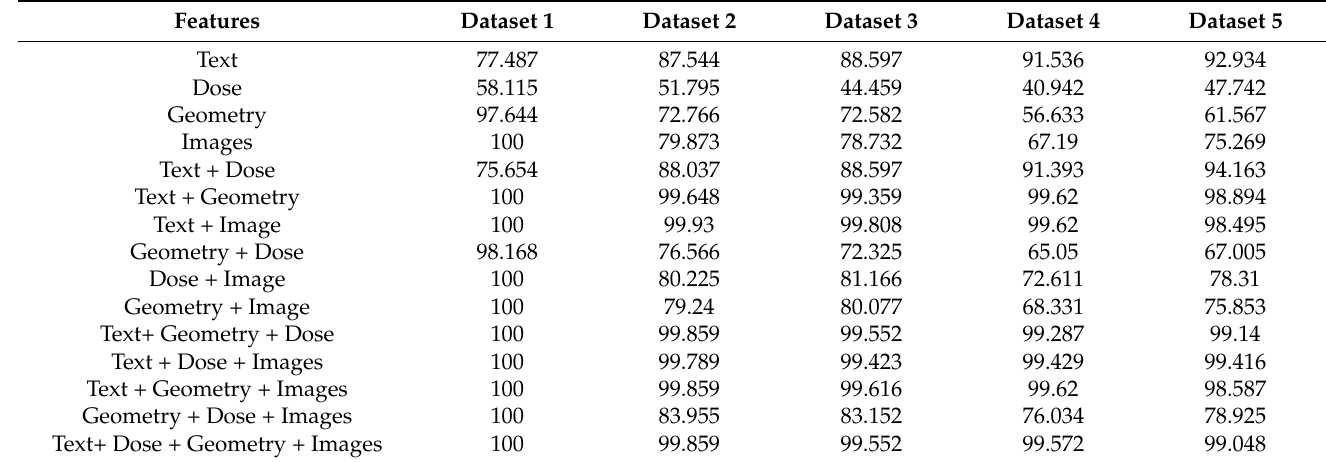
Table 5. Classification accuracy over the extended test